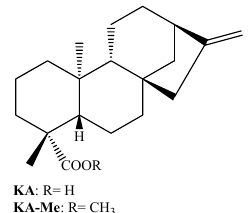
Figure 2. Chemical structure of kaurenoic acid (KA) and its respective methyl ester (KA-Me).